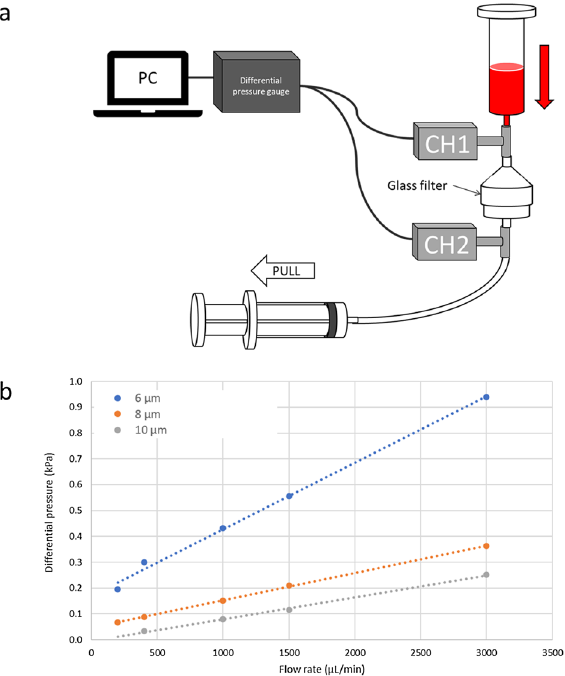
Figure 2. Measurements of the differential pressure of glass filters for capturing CTCs and CAFs. ( a ) Schematic of the experimental setup for measuring the differential pressure of the glass filters. ( b ) The relationship between the flow rate and differential pressure of the glass filters with holes (hole diameter of 6, 8, or 10 μm).